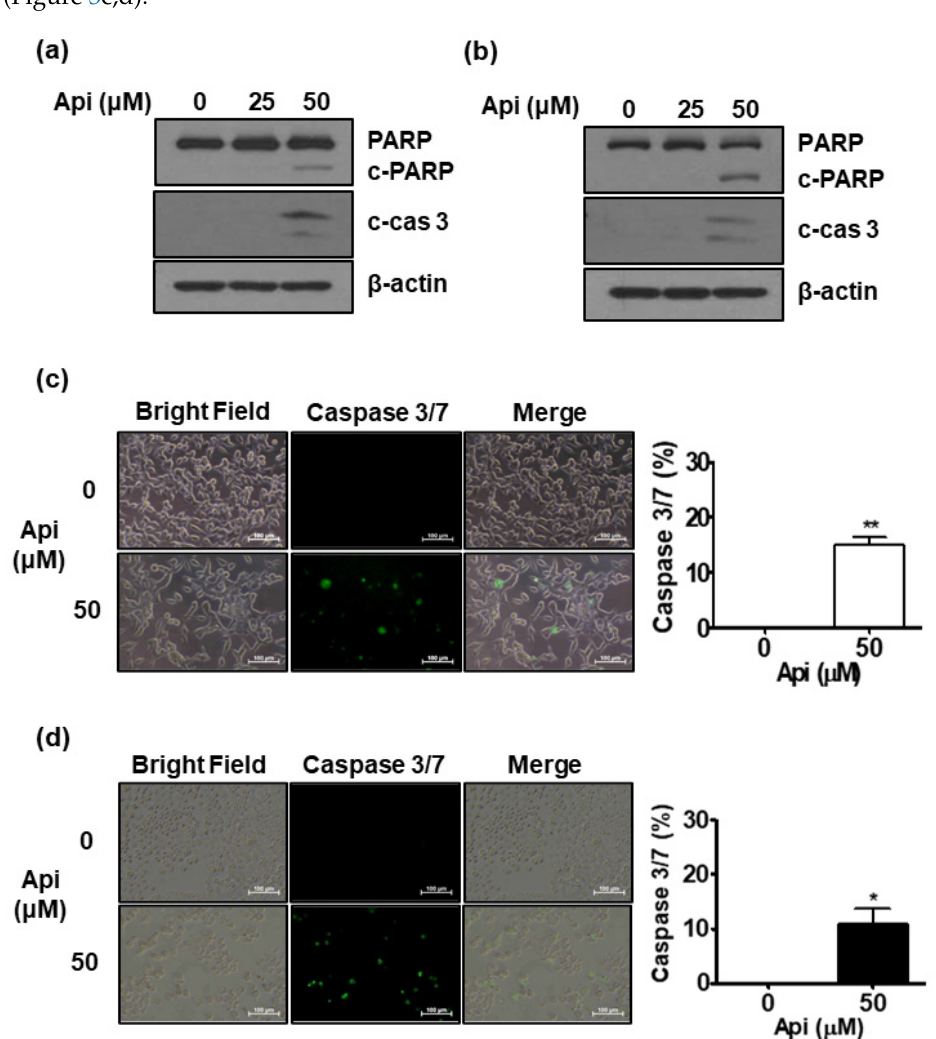
Figure 3. Effect of apigetrin on apoptosis in LNCaP and PC-3 cells. LNCaP ( a ) and PC-3 ( b ) cells were treated with apigetrin (25 and 50 μ M) for 48 h. The lysates were subjected to western blotting for PARP, caspase-3, and β -actin. After treatment of LNCaP ( c ) and PC-3 ( d ) cells with apigetrin, the cells were stained with Cell Event TM (caspase-3/7) live dye. Fluorescent apoptotic bodies were counted and expressed as means ± SD. * p < 0.05 and ** p < 0.01 vs. control.